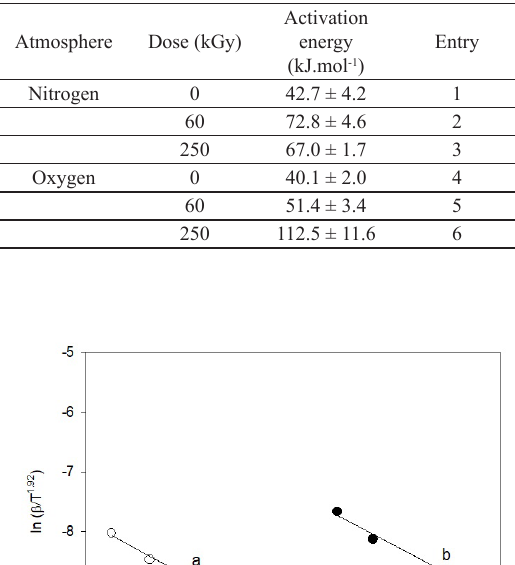
, calculated by isoconversion a